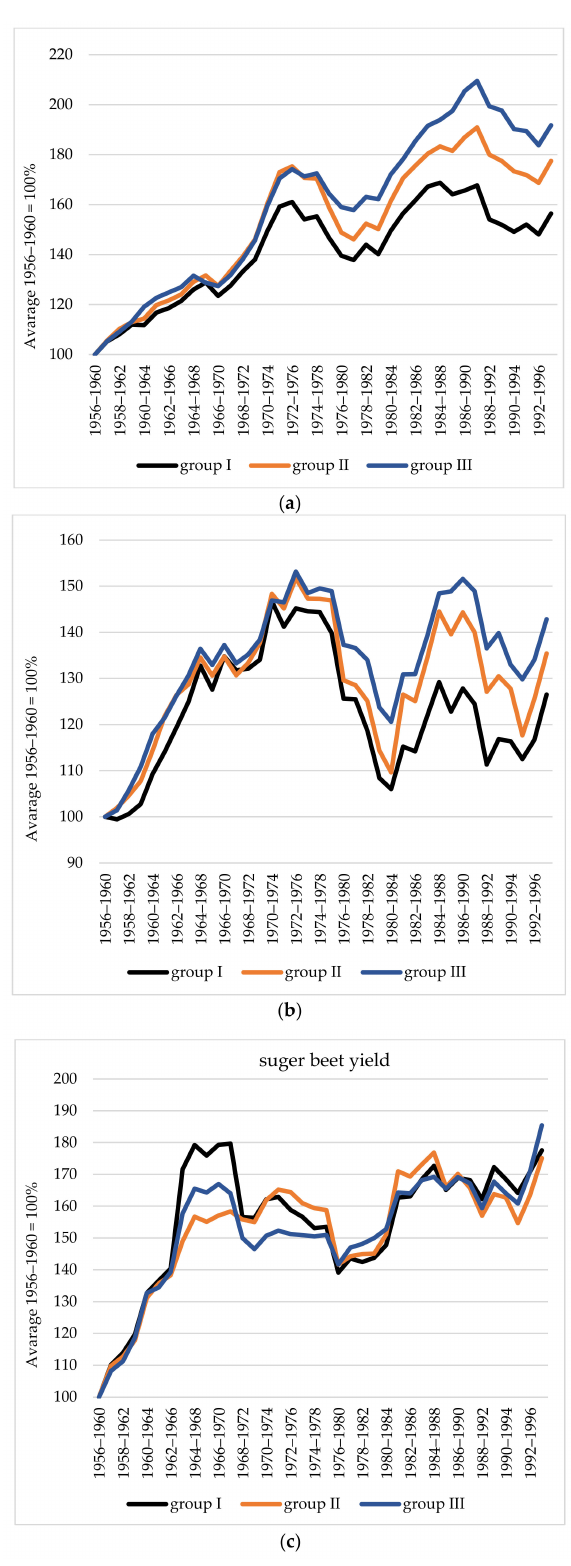
Figure 4. Yield level dynamics of selected crops depending on the distance from the open-cast mines (according to the data from the analyzed voivodships): ( a ) cereal; ( b ) potato; ( c ) sugar beet. Source: Based on